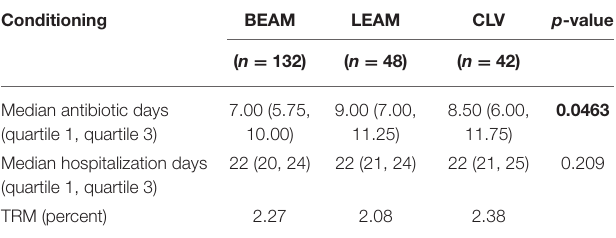
The bold values represent statistically significant